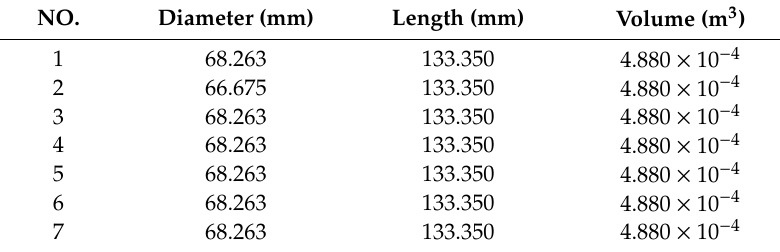
Table 1. The characteristics of 7